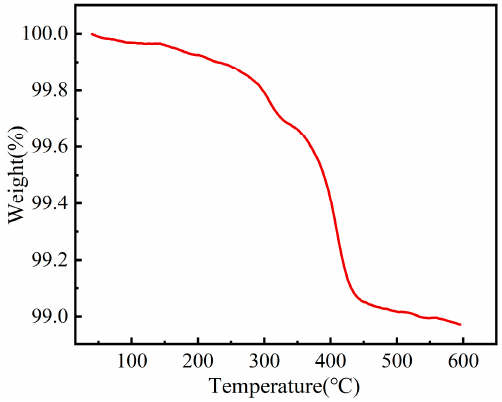
Figure 6. TG curve of silver nanowire film.